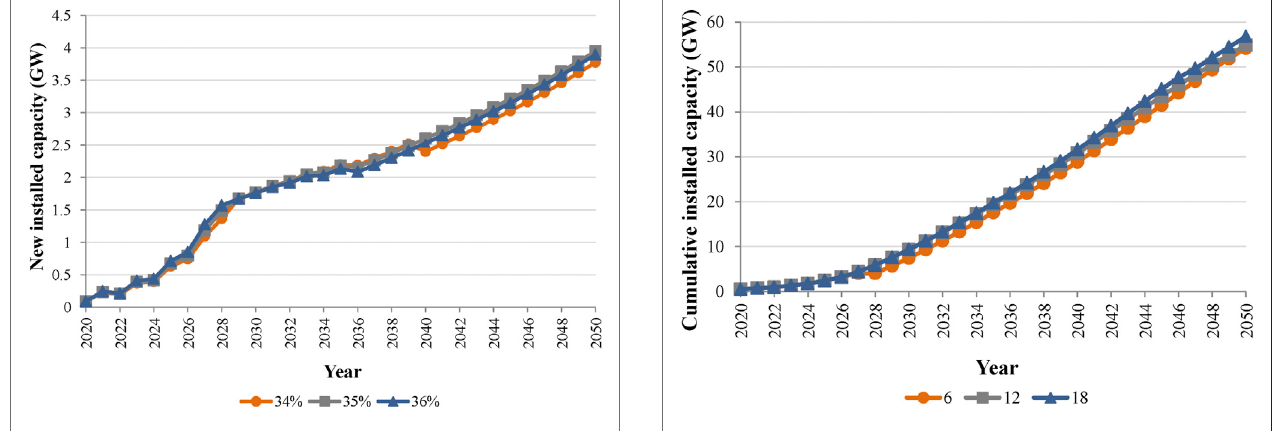
FIGURE 9 | New installed capacity under different grid absorptive capacities.